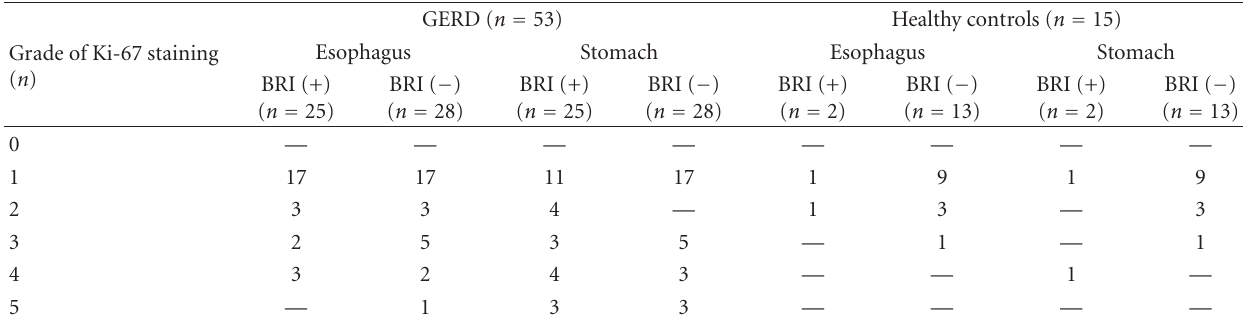
Table 6: Immunohistochemical study of the Ki-67 expression in esophageal and gastric mucosa of GERD patients and HCs. GERD ( n = 53) Healthy controls ( n = 15) Grade of Ki-67